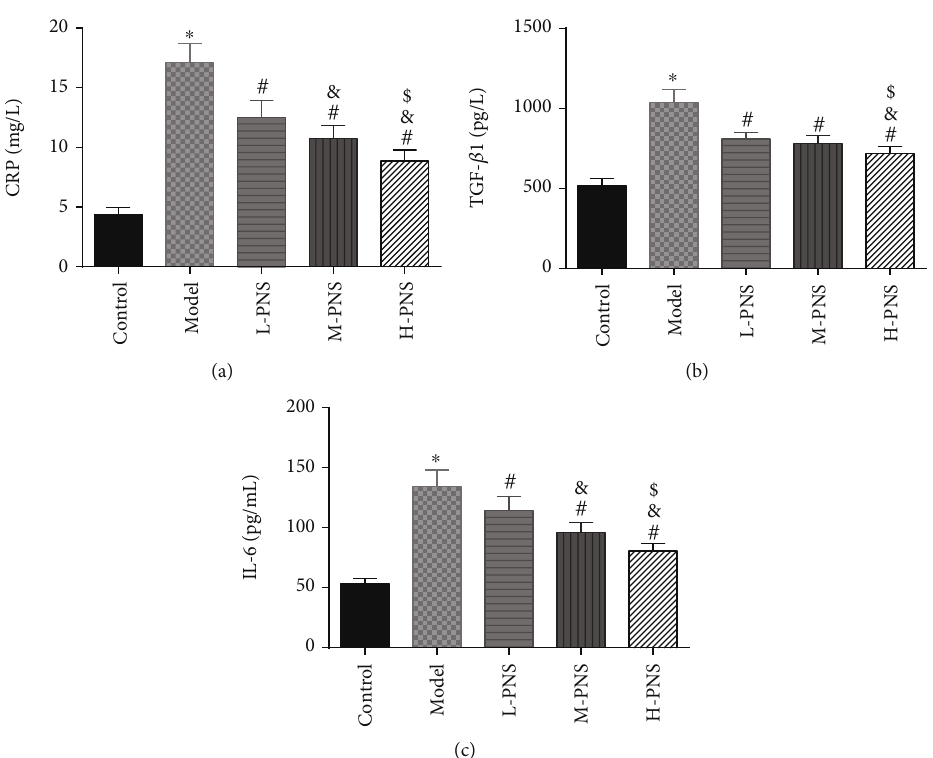
Figure 5: Changes of in fl ammatory factors in renal tissue ((a) CRP level. (b) TGF- β 1 level. (c) IL-6 level; ∗ P < 0 : 05 vs. control; # P < 0 : 05 vs. model; & P < 0 : 05 vs. L-PNS; $ P < 0 : 05 vs.